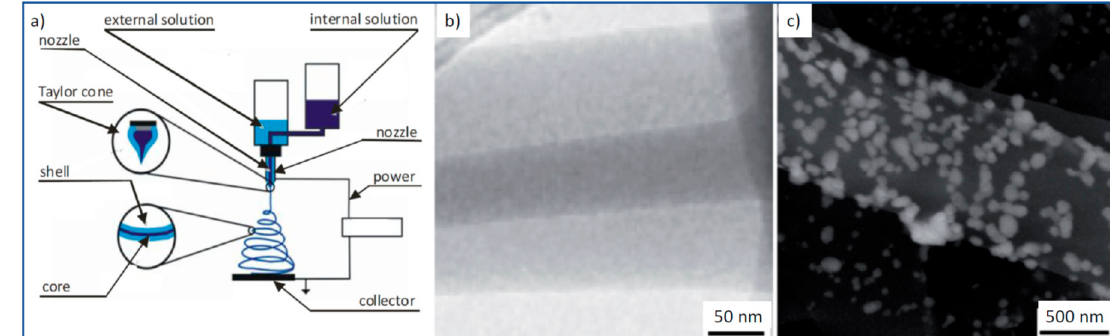
Figure 35. Manufacturing of polymer nanofibers by electrospinning for application in regenerative medicine: ( a ) scheme of the manufacturing method; ( b , c ) geometrical characteristics of the core-shell composite obtained from ( b ) a coating solution of 10% polycaprolactone without additives and inner core solution of 4% of polycaprolactone without additives (TEM), ( c ) double-component fibers obtained by dissolving PCL granulate with the molecular mass of Mw = 70,000–90,000 g/mol using 10% mixture of hydrochloric acid and formic acid with a mass ratio of 70:30 with the addition of 25% of AgNO 3 ; the photograph was taken after precipitation of silver in 2% ascorbic acid solution (SEM).